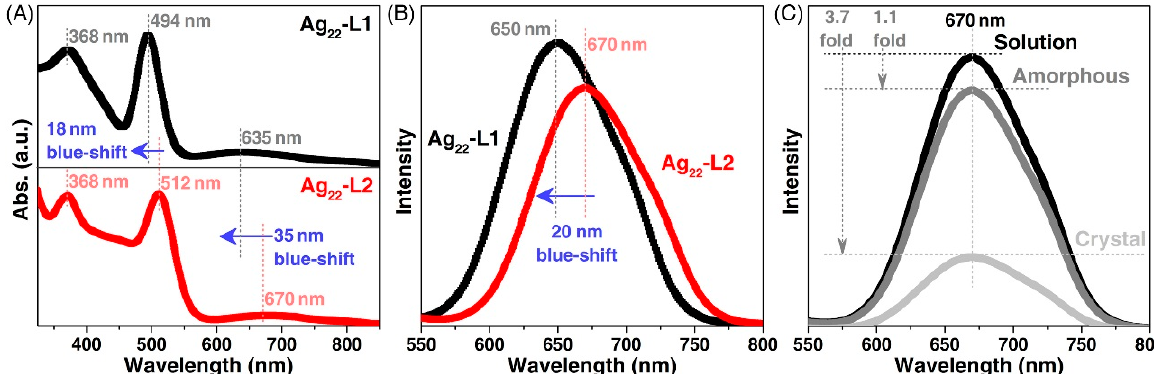
Figure 4. Comparison of optical properties between two Ag 22 nanoclusters. ( A ) Comparison of optical absorptions between Ag 22 -L1 (black line) and Ag 22 -L2 (red line). ( B ) Comparison of emissions between Ag 22 -L1 (black line) and Ag 22 -L2 (red line). ( C ) Emission spectra of Ag 22 -L1 in the solution (black line), amorphous (red line), and crystalline (blue line) states.